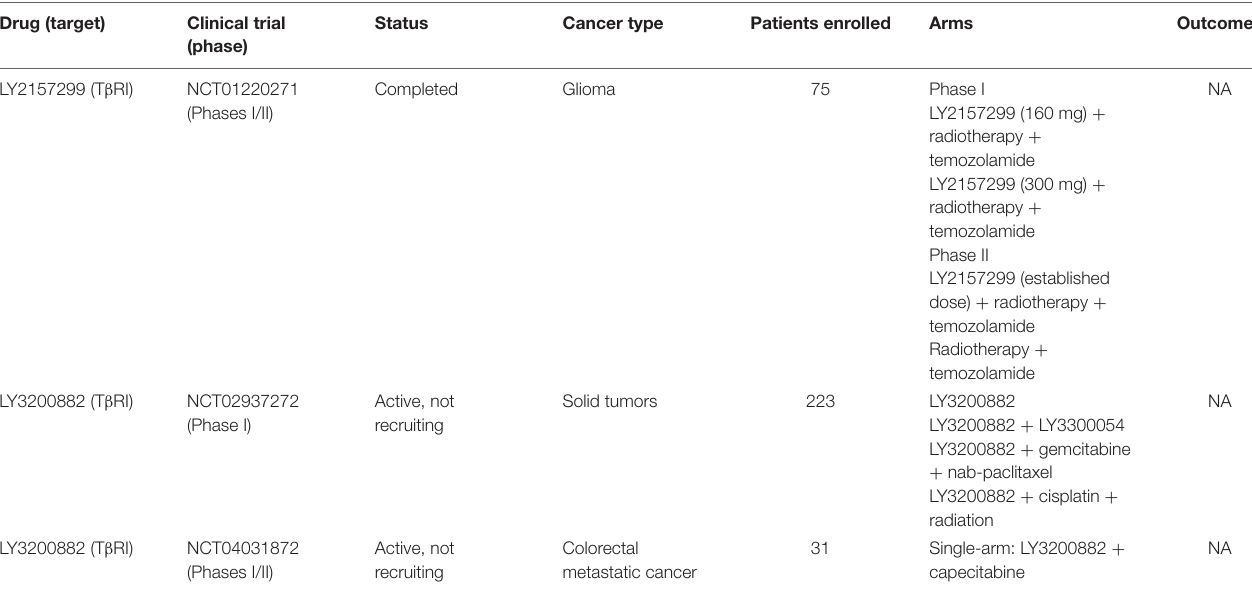
TABLE 4 | Overview of anti-TGF- β therapies based on kinase inhibitors used in cancer clinical trials. Drug